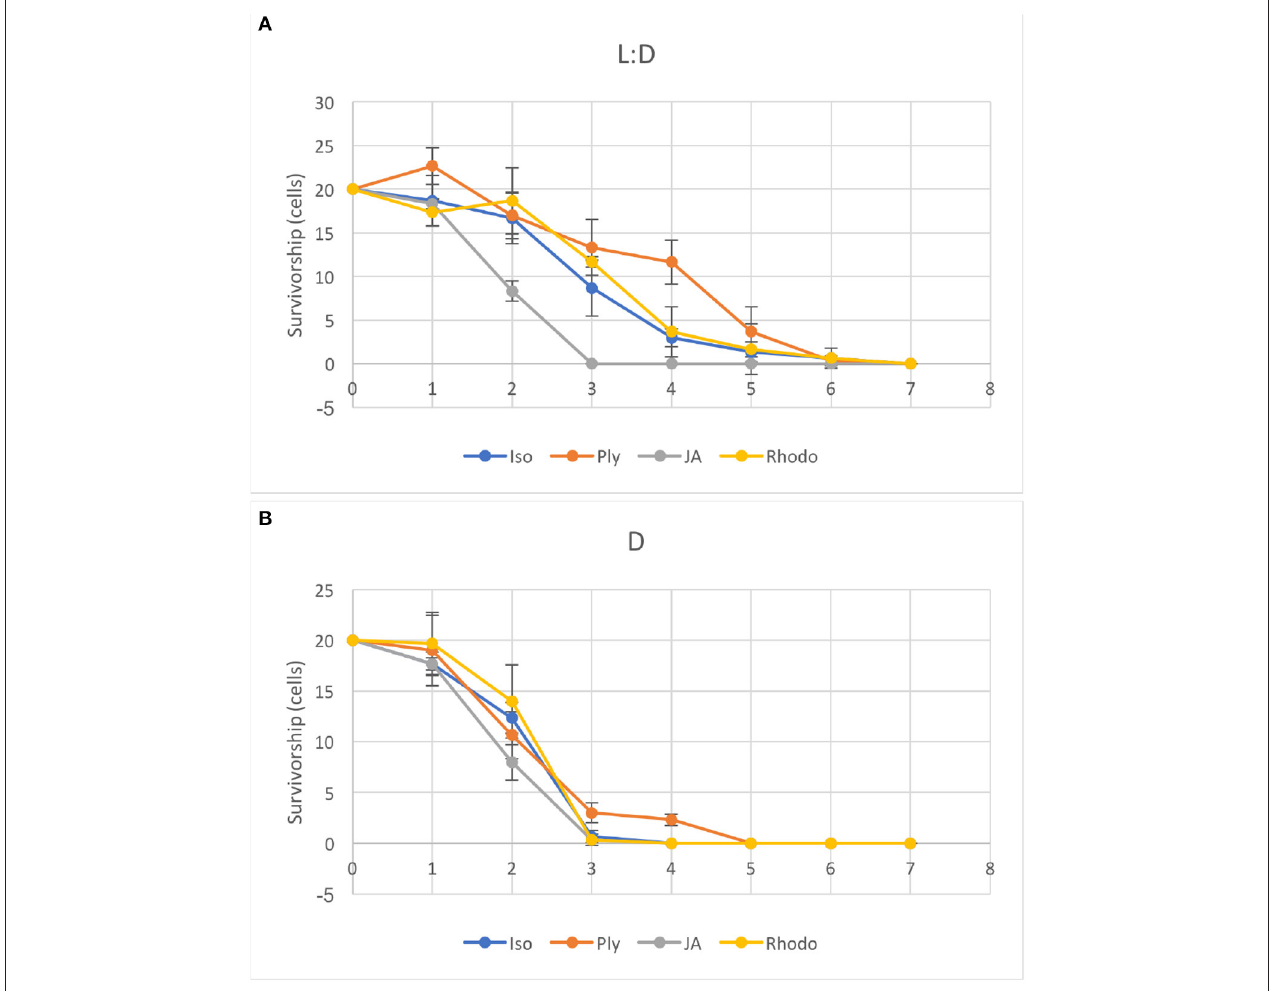
FIGURE 9 | Ciliates were starved under light ( A , 12:12 L:D photoperiod at c. 70 µ mol m − 2 s − 1 ) or dark (B) conditions after growth on four different food algae (see Table 1 for algal abbreviations). Error bars are standard deviations ( n =